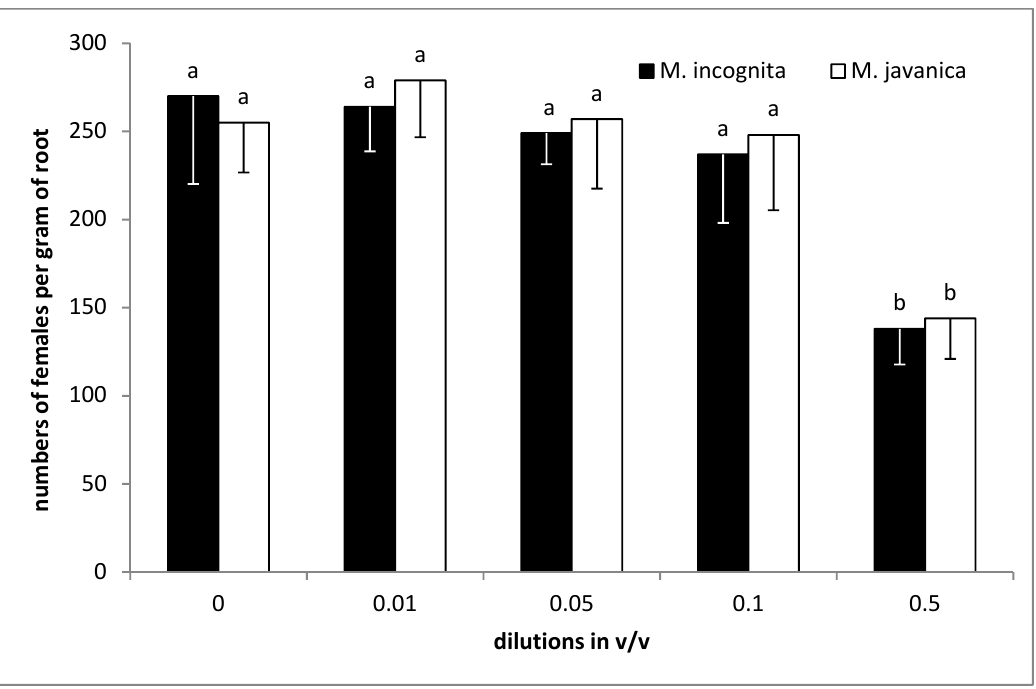
Figure 6. Numbers of females of M. javanica and M. incognita per gram of root after transplanting tomato seedlings in soil treated with hydrosol of Satureja hellenica and inoculating with 600 J2s. Bars with the same color followed by the same letter are not significantly di ff erent. Error bars represent the standard deviation of